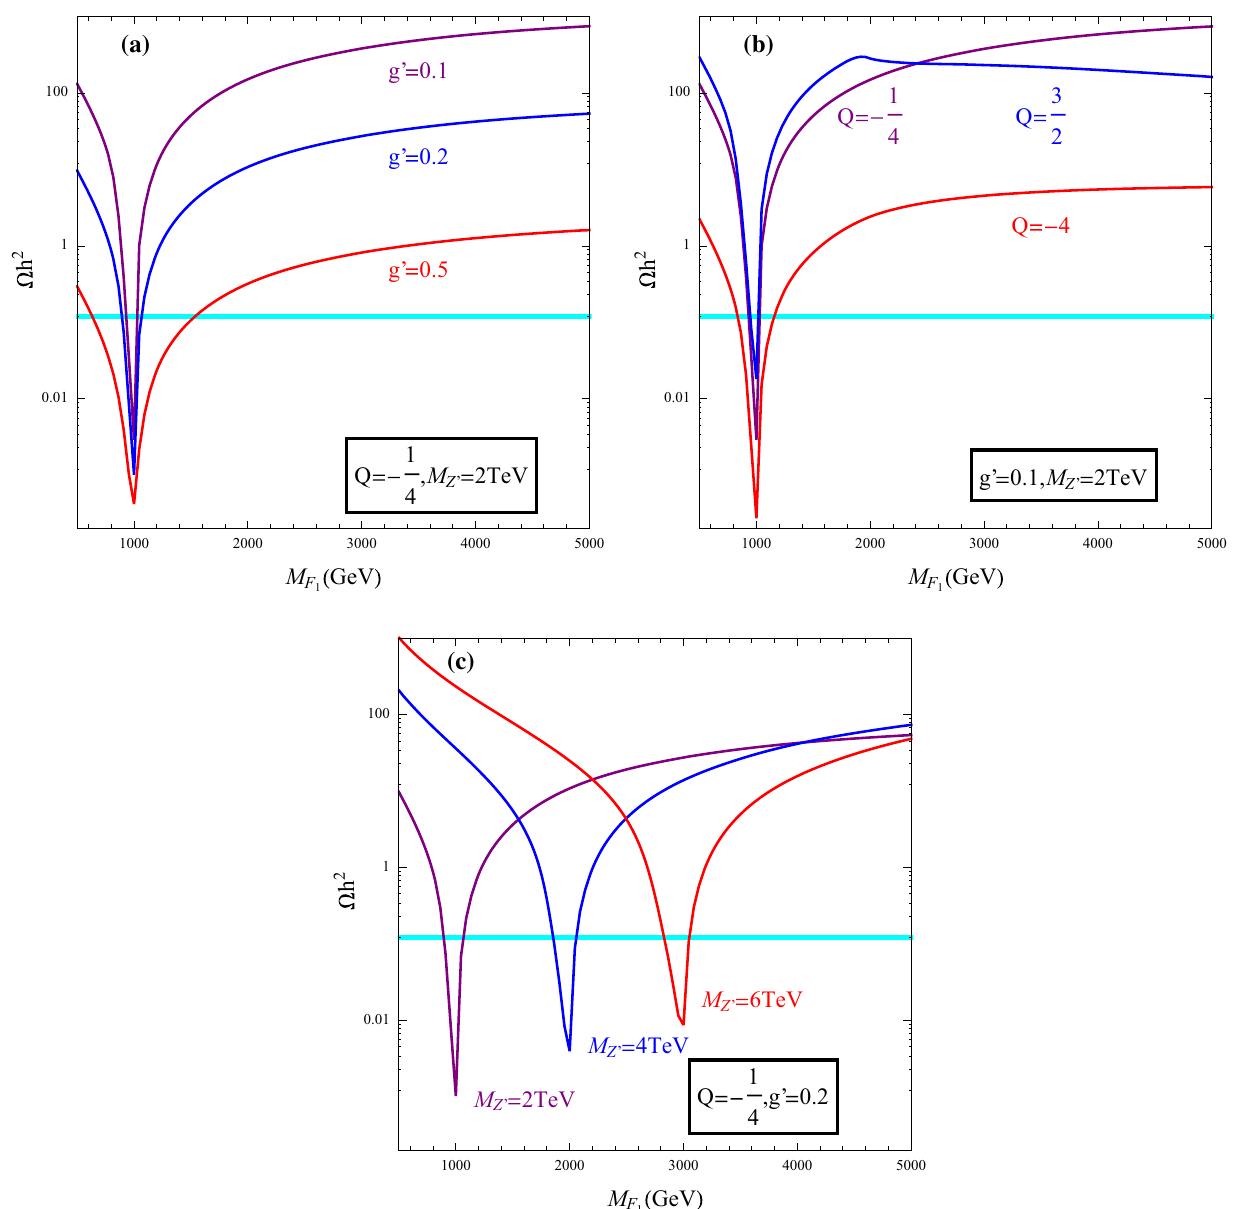
Fig. 7 Relic density as a function of fermion DM mass M F , − 4 , 3 Q = − 1 . c Q = − 1 , g (cid:2) = 0 . 2, M Z (cid:2) = 2 , 4 , 6 TeV. The cyan band corresponds to Planck measured result (cid:20) h 2 = 0 . 1199 ± 0 . 0027 4 2 4